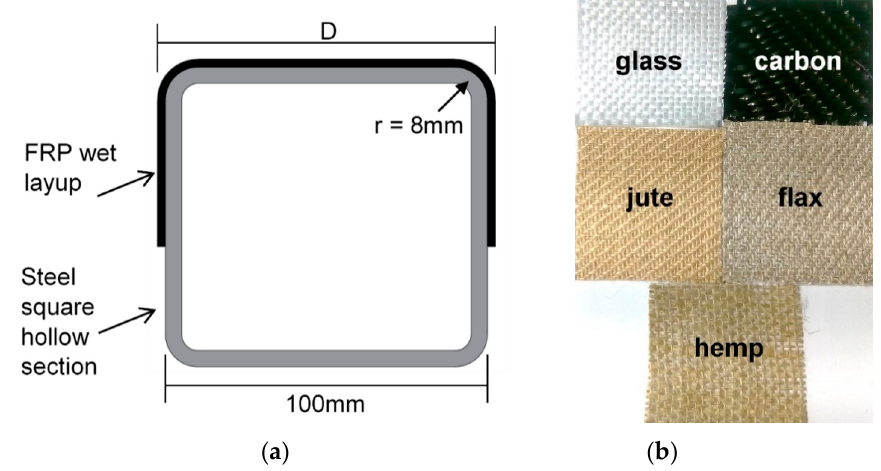
Figure 1. Mandrel and fiber fabrics used: ( a ) steel square hollow section mandrel and ( b ) 50 × 50 mm